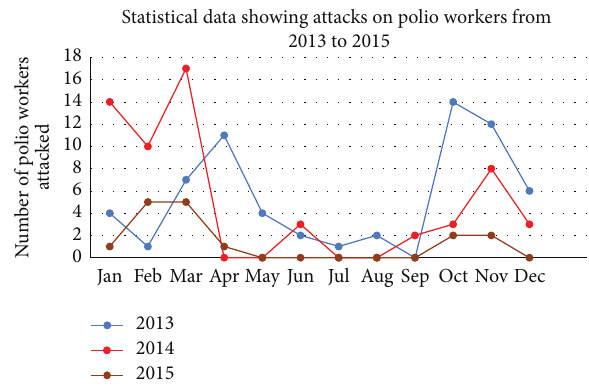
Figure 2: Showing number of attacks on polio workers during 3 years (2013–2015) adopted and modified from